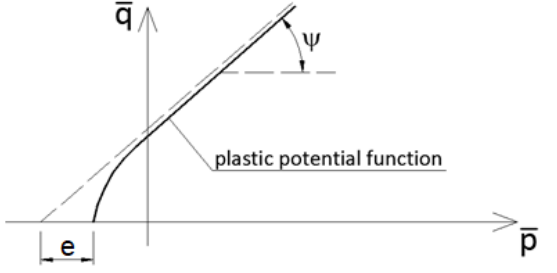
Figure 2. CDP plastic flow potential surface in the meridian plane.